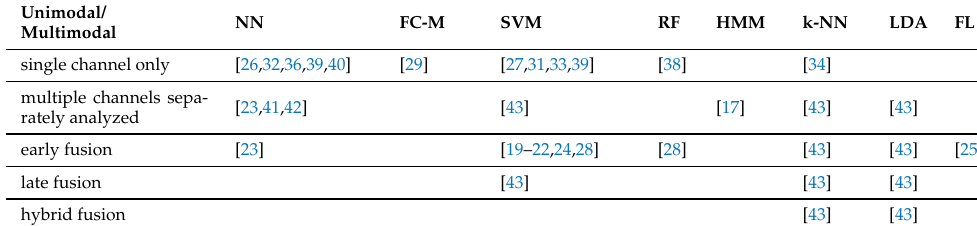
Table 9. Unimodal or multimodal approaches corresponding to machine-learning